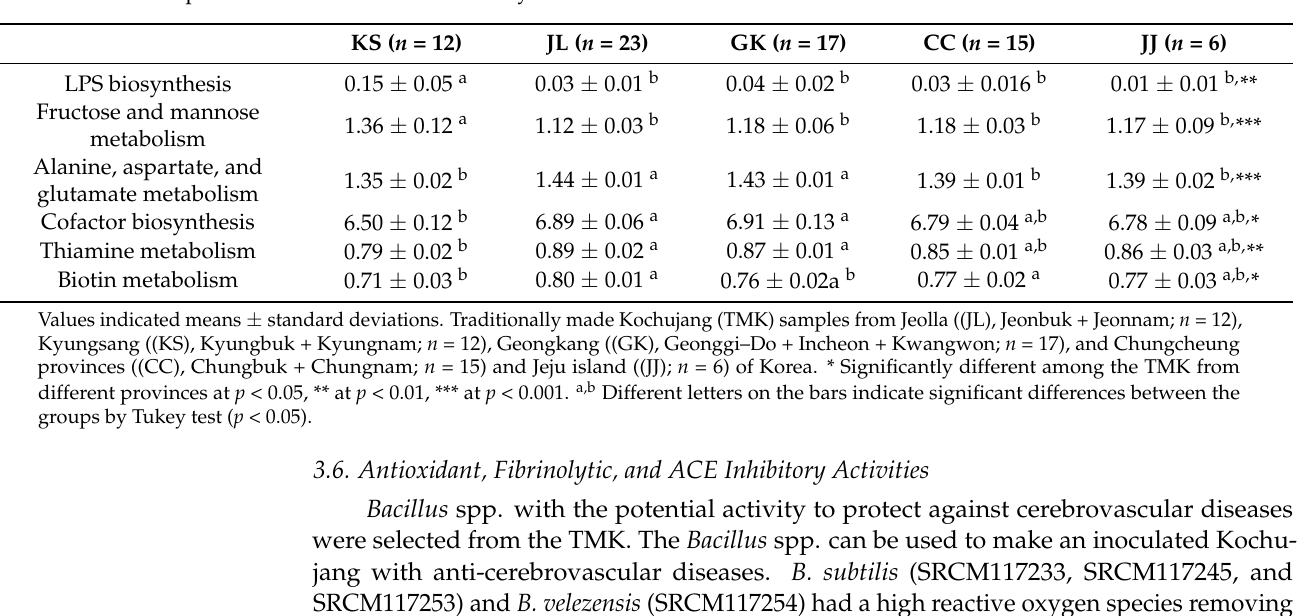
Figure 4. Bacterial communities of traditionally made Kochujang (TMK). ( A ) Relative abundance at the family level of bacteria. ( B ) Relative abundance at the genus level of bacteria. ( C ) Percentage of known beneficial bacteria at the species level. ( D ) Percentage of known harmful bacteria at the species level. ( E ) Percentage of restricted bacteria for food usage at the species level. TMK samples from Jonlla (Chonbuk + Chonnam; n = 23), Kyungsang ((KS) Kyungbuk + Kyungnam; n = 12), Gyungkang ((GK) Gyunggi-Do + Kwangwon; n = 17), Chungcheung provinces ((CC) Chungbuk + Chungnam, n = 15) and Jeju island ((JJ); n = 6) of Korea. Table 2. The proportion of the Kyoto Encyclopedia of Genes and Genomes Orthology values of the TMK bacterial genes involved in respective metabolism determined by Picrust2.